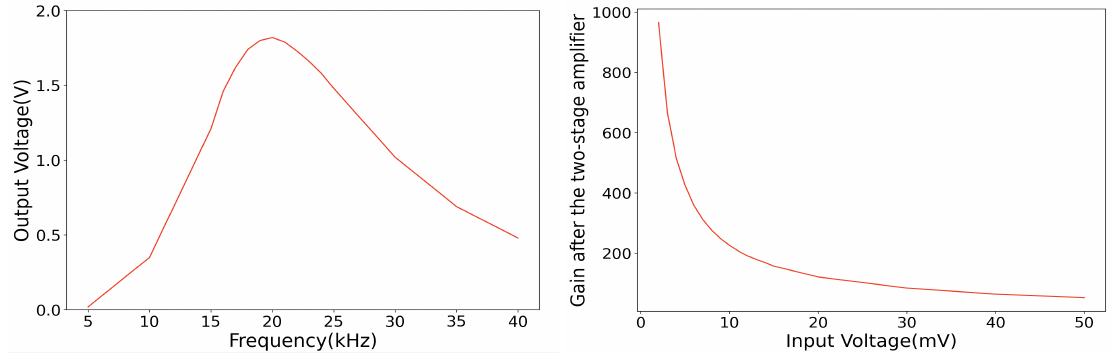
Figure 4. The filter response of the Butterworth filter (input voltage: 20 mV) and the signal gain after the Butter-worth filter and the logarithmic amplification.